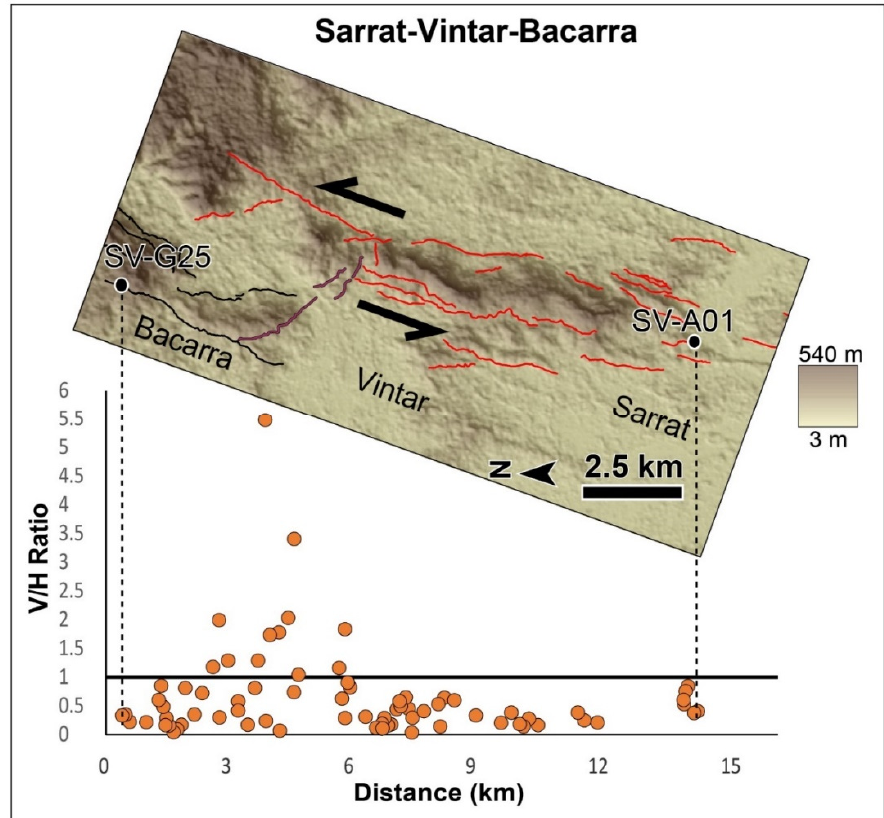
Figure 11. Map of the trace from Sarrat to Bacarra (labeled ‘f’ in Figure 2A) above the offset plot for this part of the Vigan-Aggao Fault. The fault zone is also marked, at a smaller scale, by a bend within a left-step gap. Higher V/H values correspond to the gap between the left-stepping segments. The Sarrat-Vintar-Bacarra segment is traced in red, while the southern portion of the Bacarra-Burgos segment is traced in black. The transition between these segments is traced in violet. Geosciences 2020 , 10 , x FOR PEER REVIEW